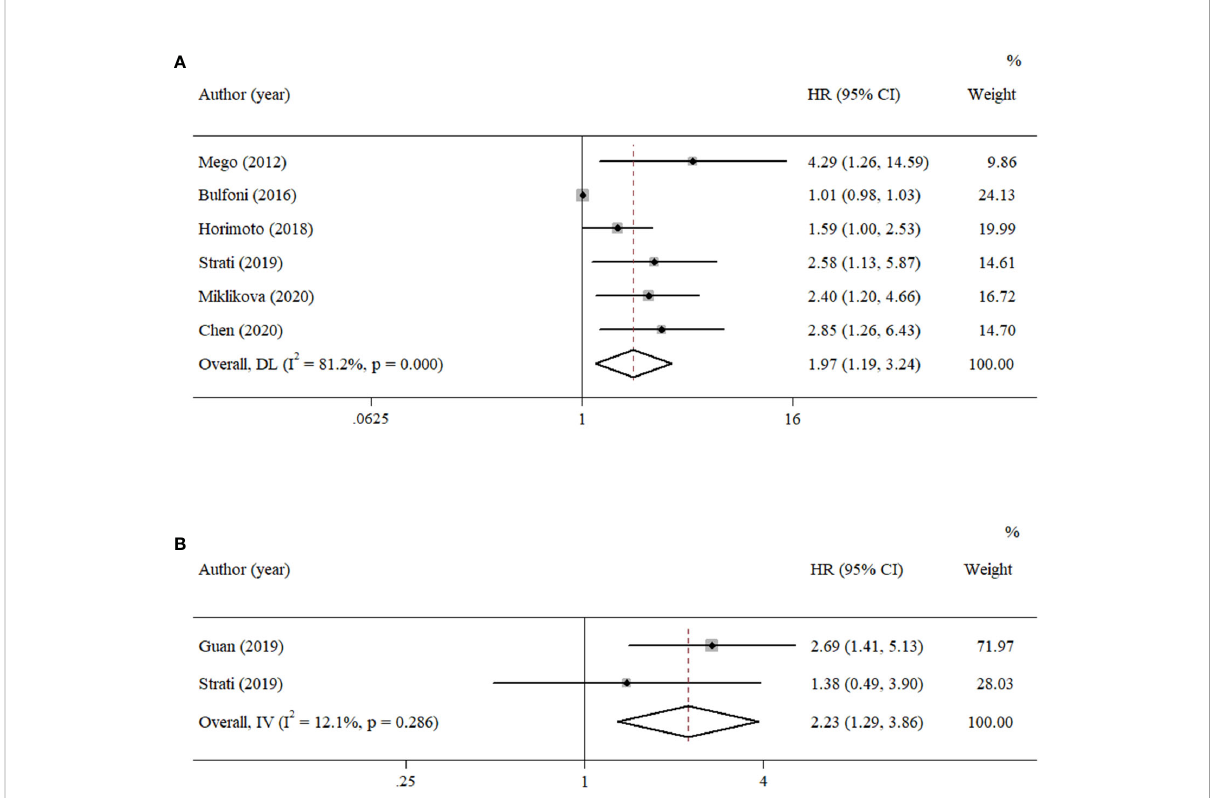
FIGURE 2 Forest plots of the pooled HRs for PFS with (A) univariate analysis and (B) multivariate